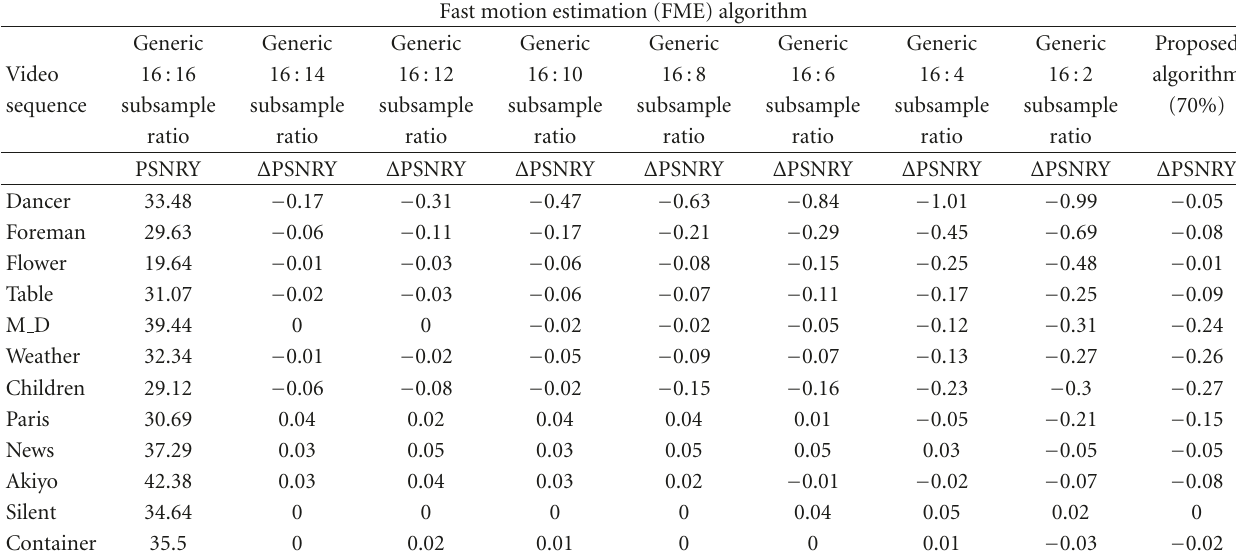
Table 7: Performance analysis of quality degradation for various video sequences using various methods. (Note that the proposed algorithm can always keep the quality degradation